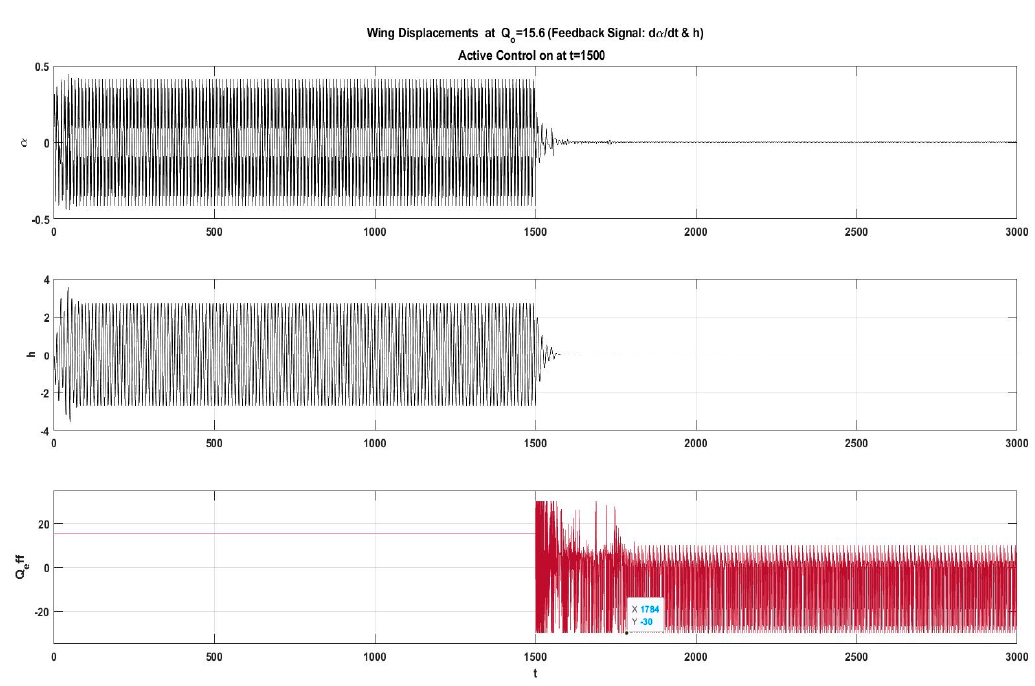
Figure 21. A comparison of aeroelastic responses ( Q o = 15.6 ) .